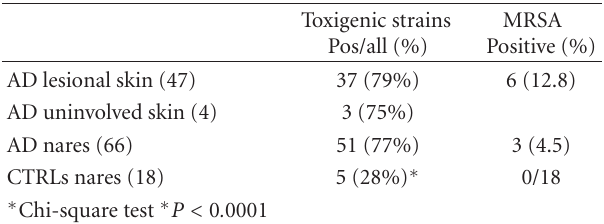
Table 4: Prevalence of S. aureus toxigenic strains in atopic and healthy